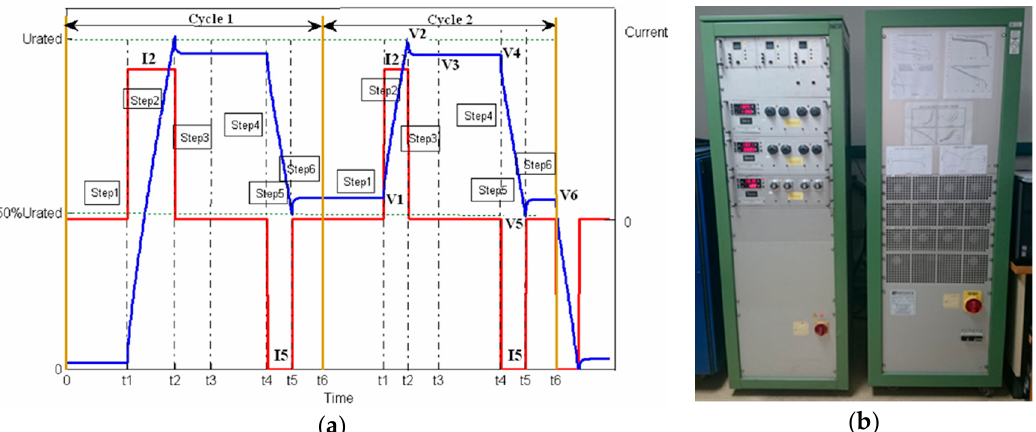
Figure 4. ( a ) Voltage profile referred to time applied to SCs to calculate the C and the ESR SC; ( b ) Digatron BTS-600.